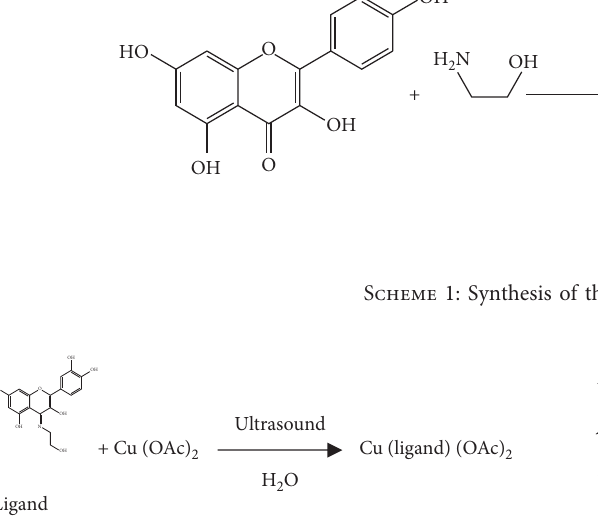
Scheme 2: Synthesis of the novel